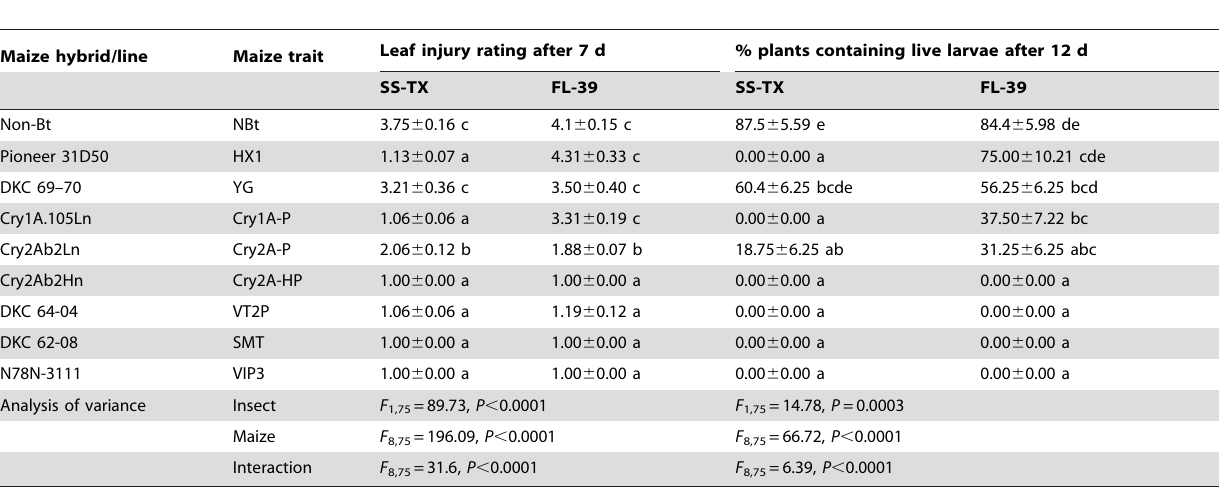
Table 4. Leaf injury rating and % plants containing live larvae (mean 6 SEM) of Cry1F-susceptible (SS-TX) and -resistant (FL-39) strains of Spodoptera frugiperda on whole plants of non-Bt and Bt maize containing single or pyramided genes.